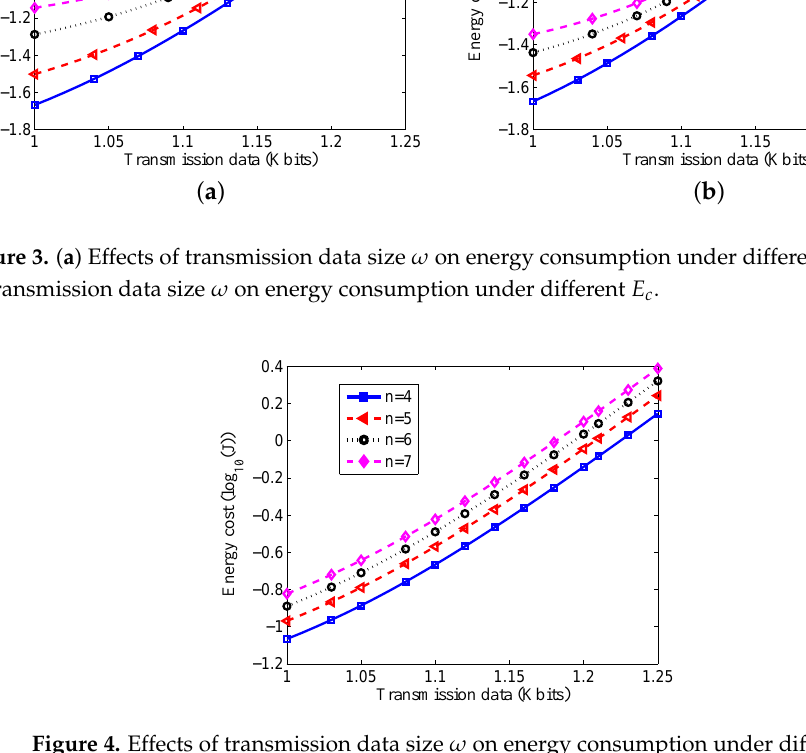
Figure 4. Effects of transmission data size ω on energy consumption under different n